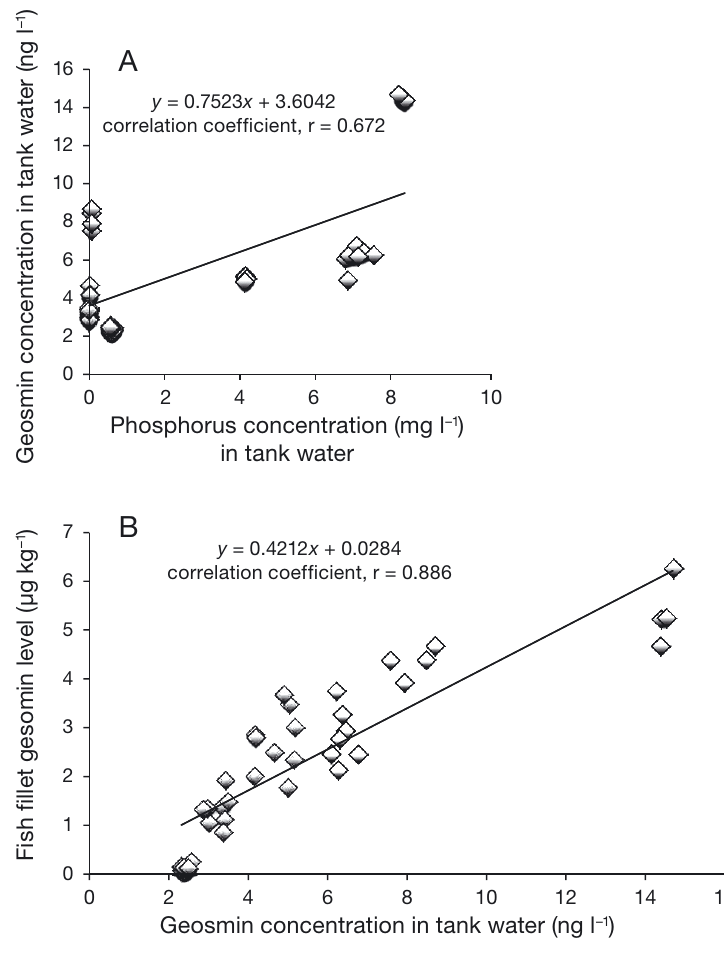
Fig. 4. Oncorhynchus mykiss . Linear correlations between (A) the phosphorus and geosmin concentrations in tank water and (B) the geosmin concentration in tank water and that in fish fillets from the feeding trial where fish received low-phosphorus (LP) and high- phosphorus (HP) diet. Data are means (±SD) of 4 tanks per diet. Corre- lations are significant at p <